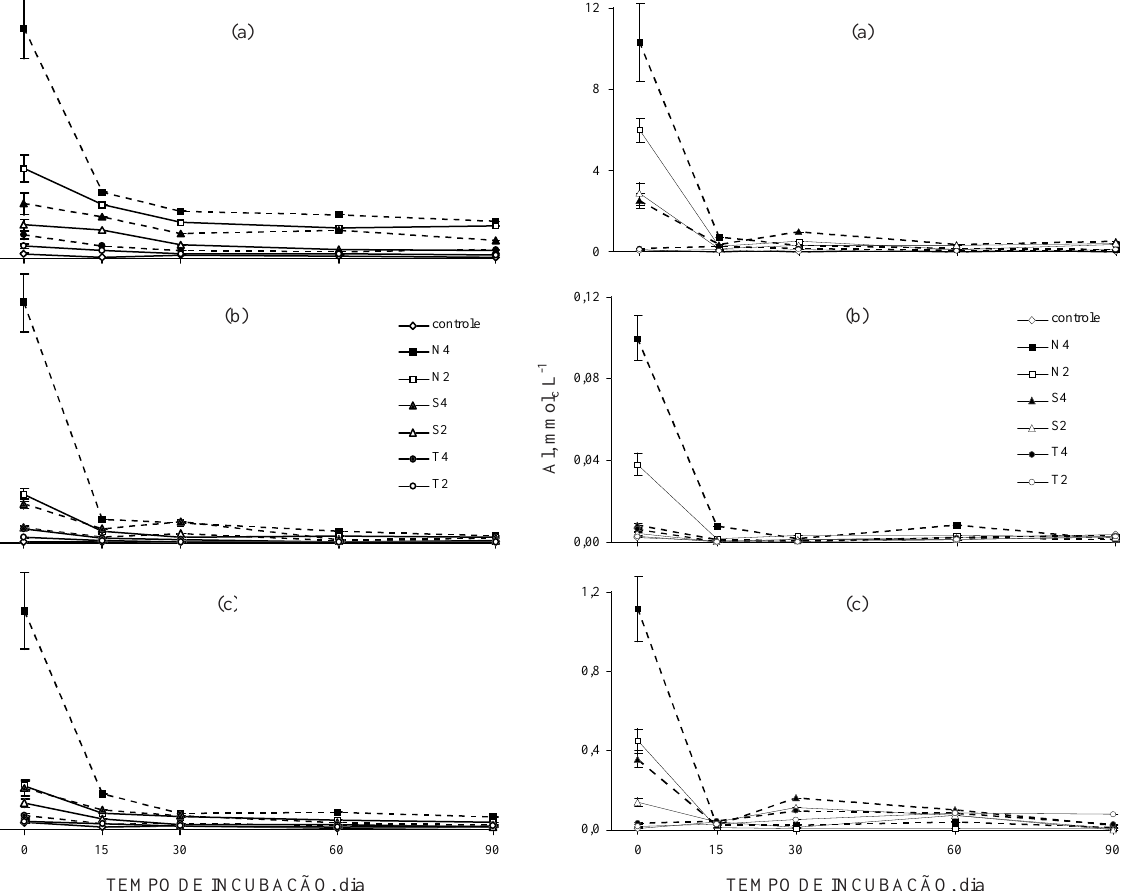
Figura 2. Efeito do tempo de incubação dos resíduos vegetais com o solo na concentração de Al-total ). (a) Latossolo Vermelho- em solução (Al t Amarelo, (b) Latossolo Roxo e (c) Latossolo Vermelho-Escuro. Barras verticais indicam o erro-padrão da